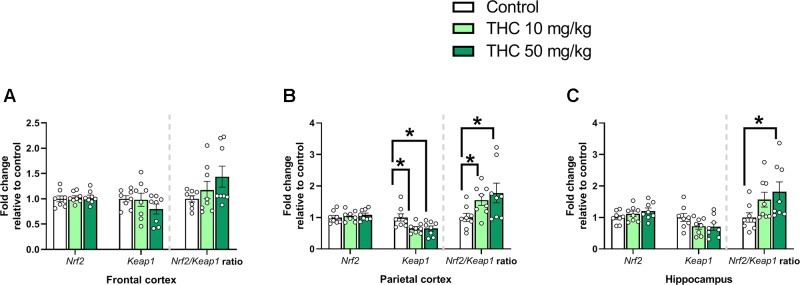
Oxidative stress genes. Transcript levels of oxidative stress genes Nrf2 and Keap1, together with a Nrf2/Keap1 expression ratio, 24 h after PND 10 exposure to vehicle, 10 mg THC/kg or 50 mg THC/kg in the (A) frontal cortex, (B) parietal cortex, and (C) hippocampus. Statistical difference from post hoc test is indicated as * if p < 0.05. Height of bars represents the mean fold change ± SEM of 8 mice.